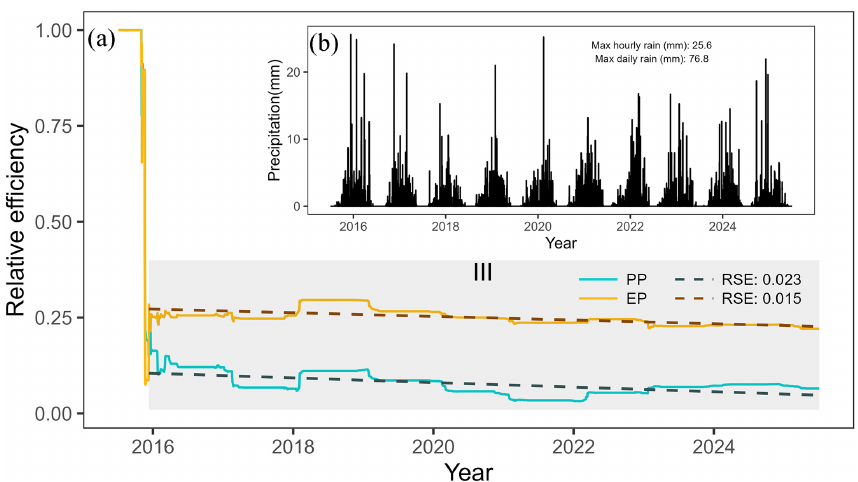
Figure 11. Rainfall input over 10 years and relative efficiency of sediment intervention measures. (a) Relative efficiency changes over 10 years (the grey region highlights stage III, and the dashed lines indicate the linear fitting curves); (b) Rainfall downscaled from the NEX-GDDP (NASA Earth Exchange Global Daily Downscaled Projections)